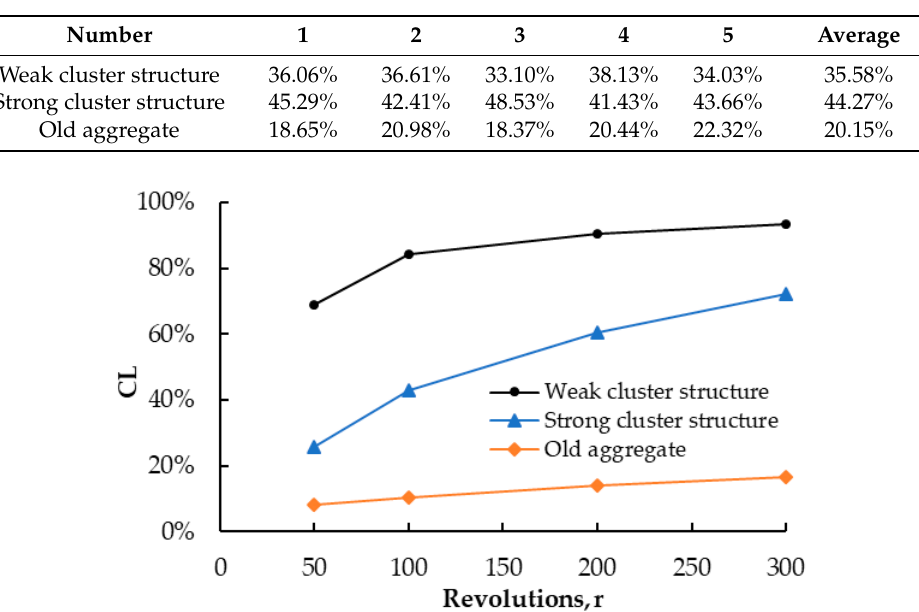
Figure 9. The Crushing Loss Rate of the Three Kinds of Structures.